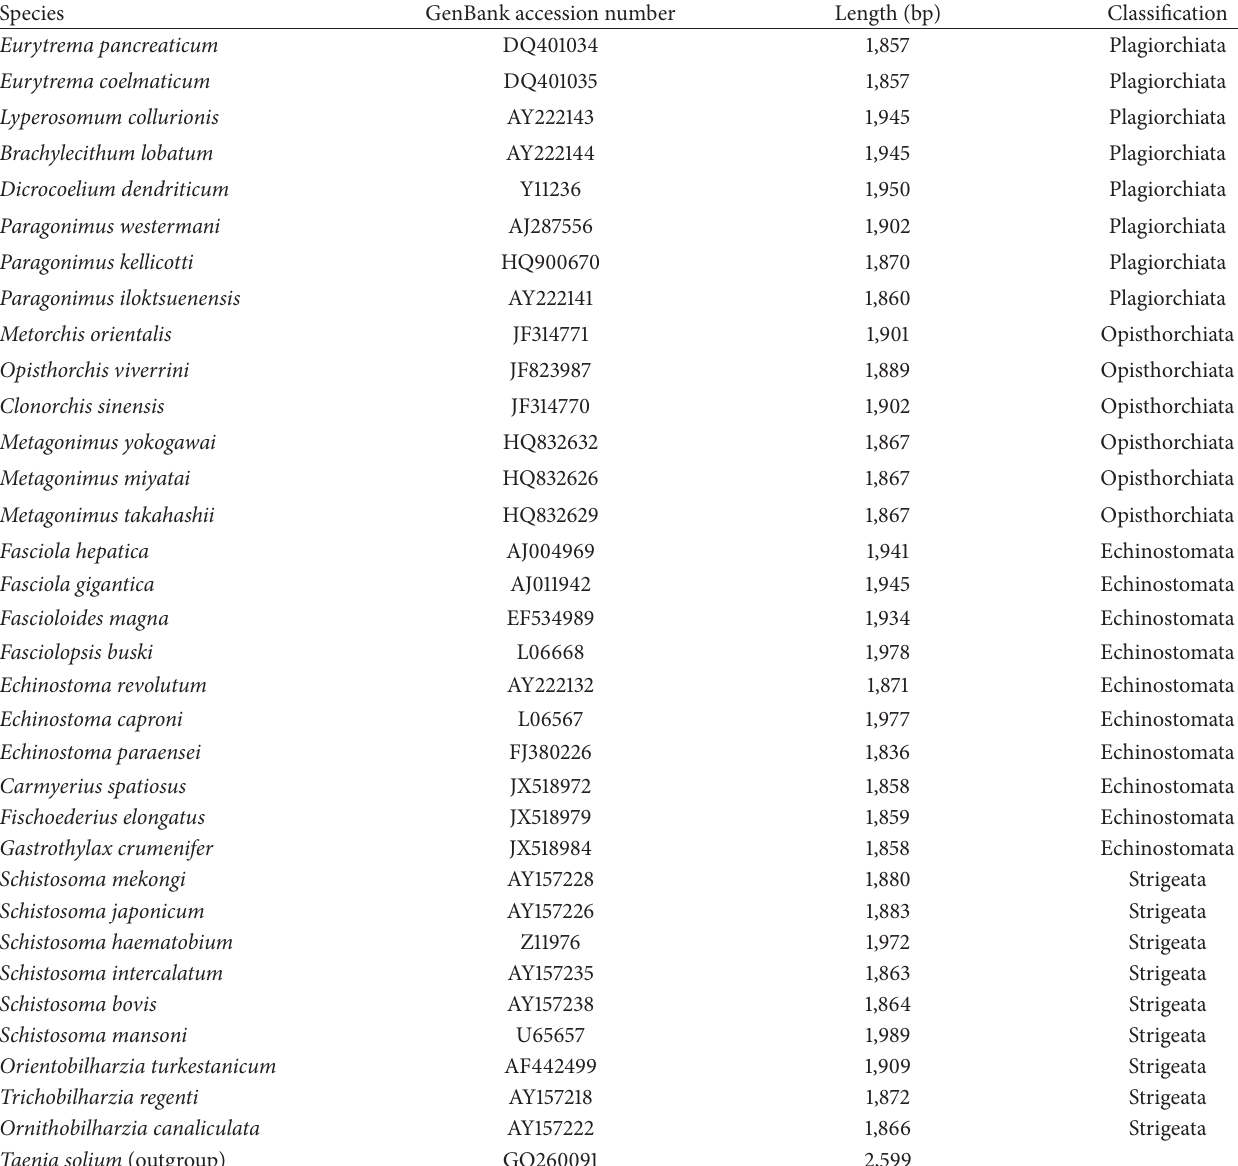
Table 2: Sequences of 18S rDNA available in GenBank used to construct phylogenetic relationships among the